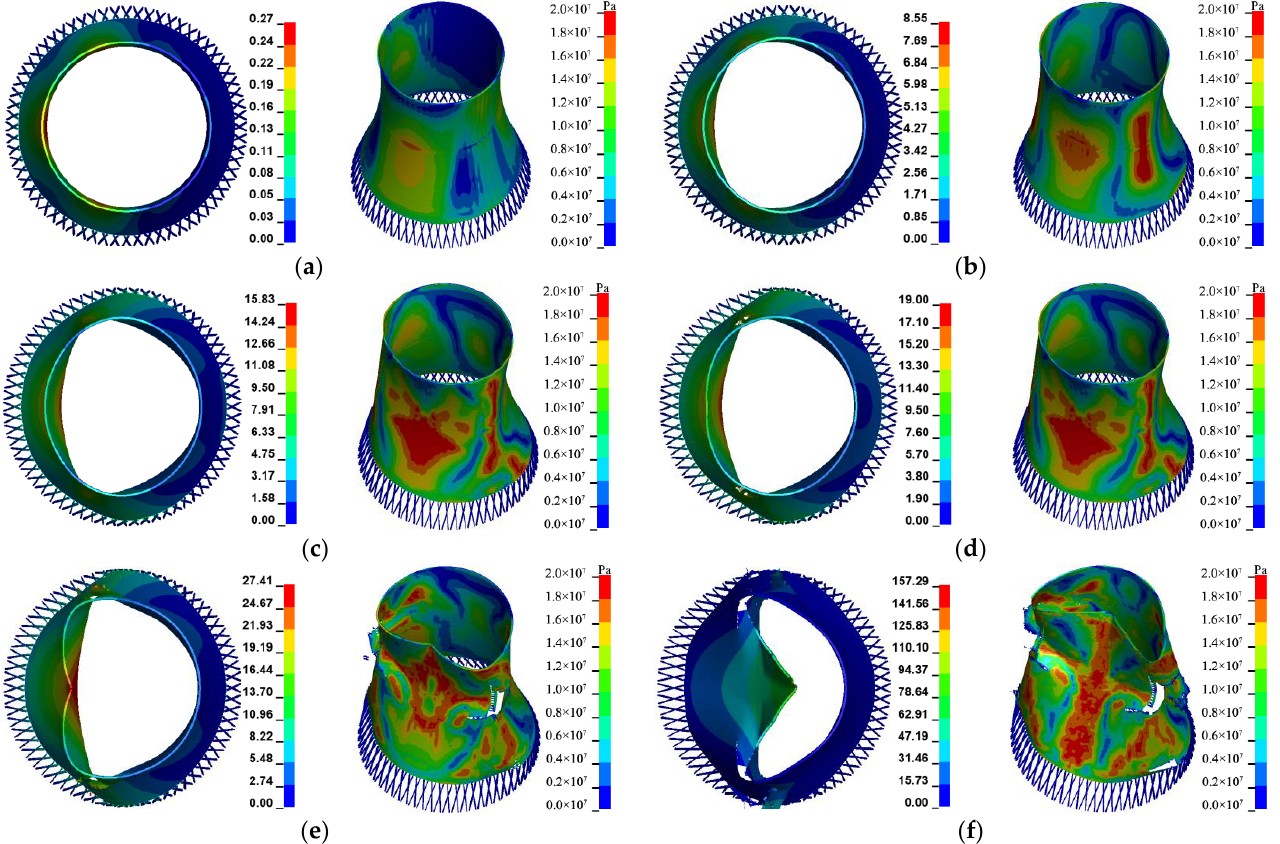
Figure 19. Schematic diagram of displacements and first principal stresses during cooling tower collapse. ( a ) t = 0.2 s. ( b ) t = 1.6 s. ( c ) t = 3.2 s. ( d ) t = 4.6 s. ( e ) t = 6.2 s. ( f ) t = 12.4 s.